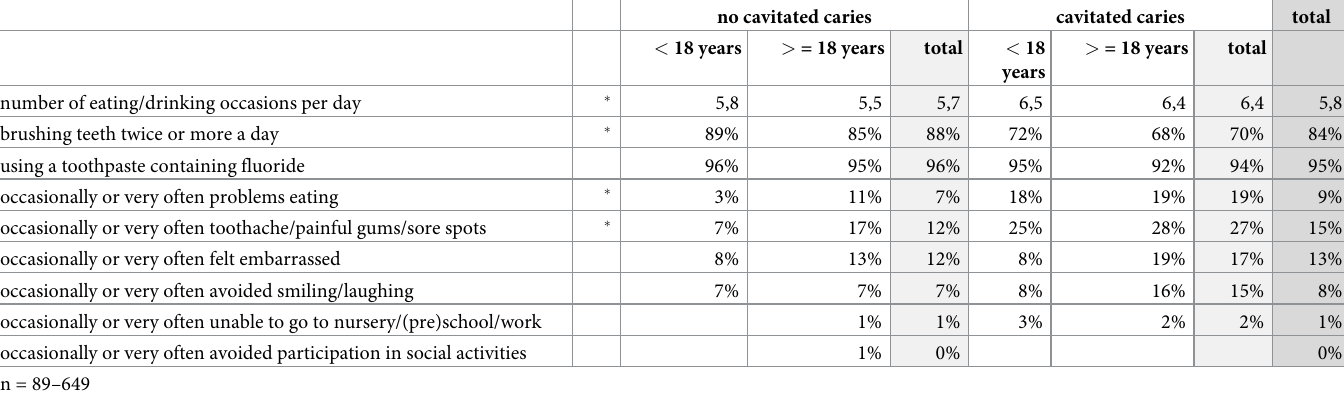
Table 5. Aspects of oral self-care and oral heath related quality of life in cohesion with the presence of cavitated caries.